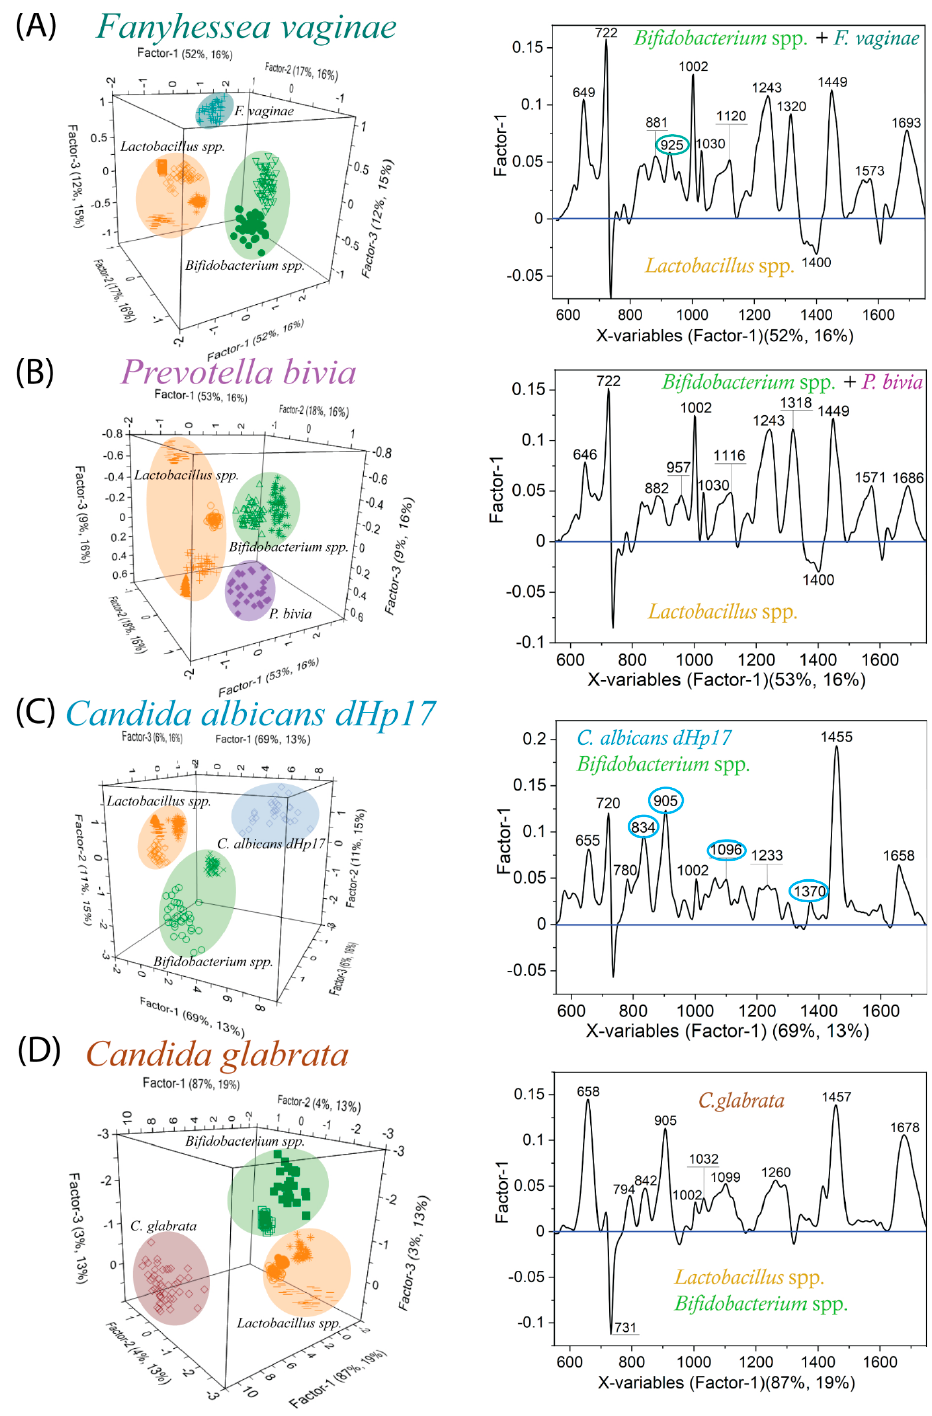
Figure 5. The results of PLSR analysis in the form of score plots and X − loading plots for various associations such as 4 chosen strains of Lactobacillus spp., 2 chosen strains of Bifidobacterium spp., and F. vaginae ( A ), P. bivia ( B ), C. albicans dHp17 ( C ), C. glabrata ( D ). All microorganisms were cultivated on MRS agar for 48